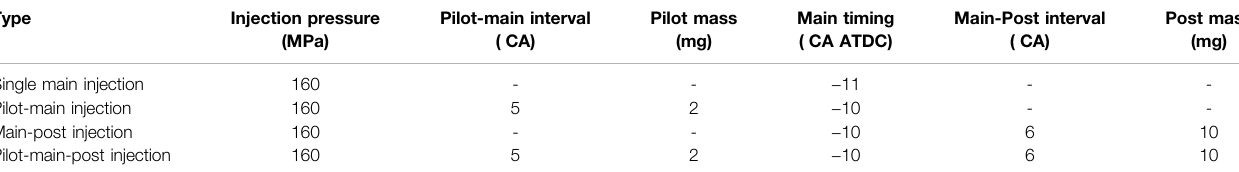
TABLE 5 | The injection settings at a given NO x emission of 17.4 g/kWh and approximate 20 MPa